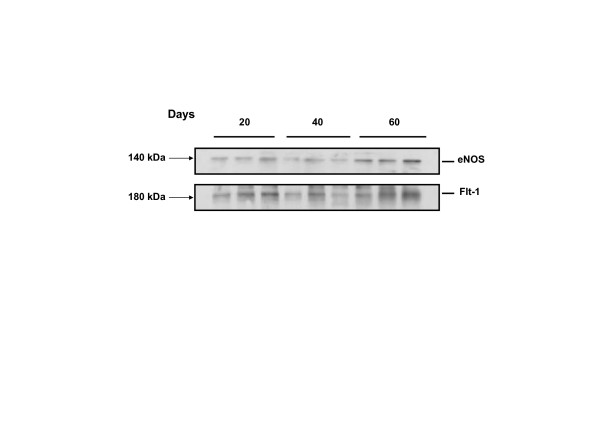
Representative blot of placental homogenates from days 20, 40 and 60 of pregnancy for FLT-1 and eNOS. Purified human Flt-1 and eNOS yielded bands with approximate molecular weights of 180 and 140 kDa respectively. No significant differences were observed between the means of the 3 homogenates included in each study period, using one-way analysis of variance and Tukey's Multiple Comparison post-hoc test.